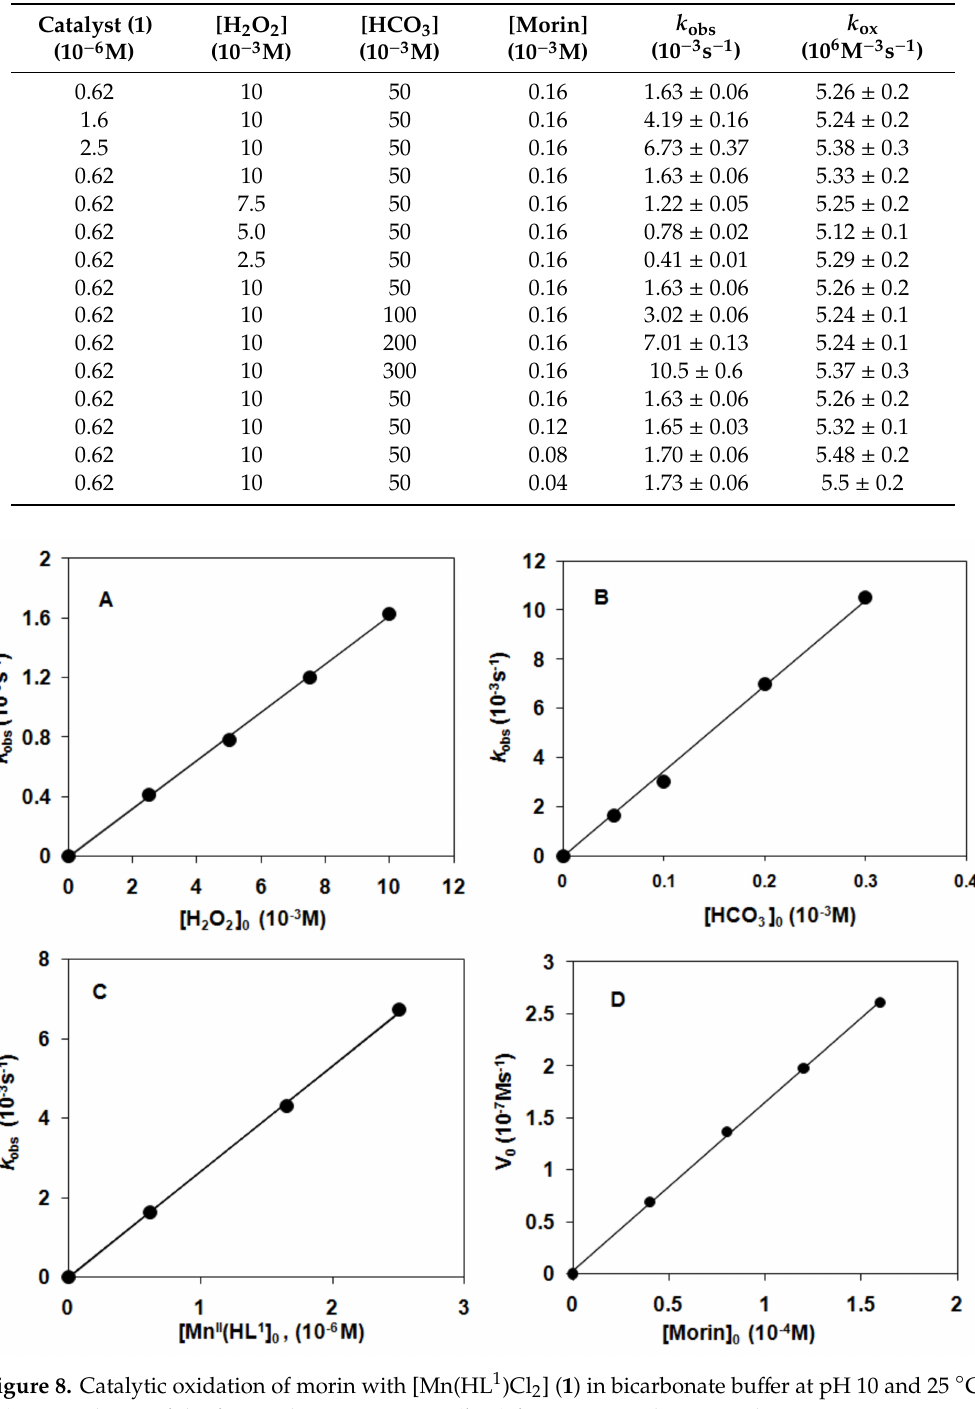
Table 3. Summary of kinetic data for the catalytic oxidation of morin with [Mn(HL 1 )Cl 2 ] ( 1 ) in bicarbonate bu ff er at pH 10 and 25 ◦ C.